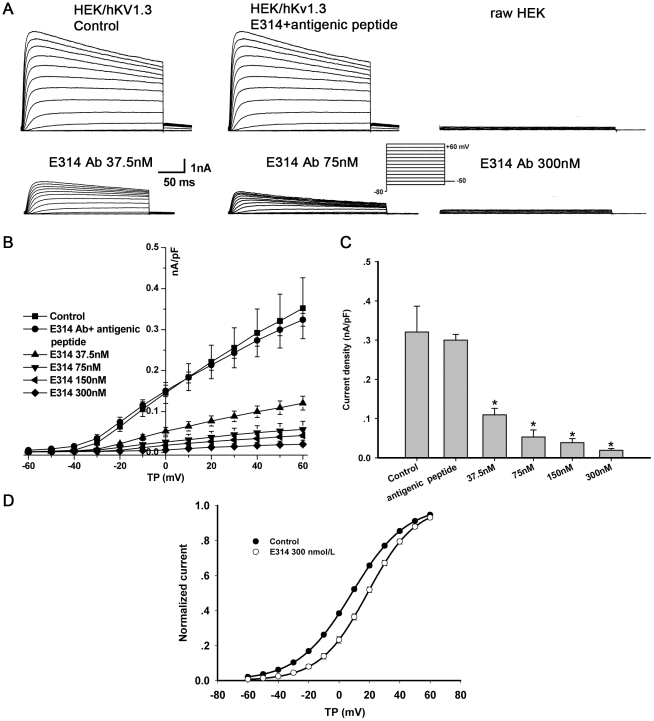
The E314 antibody inhibits human Kv1.3 currents stably expressed in HEK 293 cells.(A) IKv1.3 traces were activated at 0.1 Hz upon 250 ms voltage steps to between −60 and +60 mV (10-mV increment) from −80 mV with tail current at −50 mV in HEK 293 cells stably expressing hKv1.3 currents. The current was absent in raw HEK 293 cells. (B) The E314 antibody inhibited hKv1.3 currents in a concentration-dependent manner at test potentials from −30 to +60 mV and the inhibition was abolished by the E314 antibody preincubated with an excess of the E314 peptide, as shown in I–V relationship. (C) At depolarizing pulse +50 mV, the E314 antibody ranging from 37.5 to 300 nM inhibited hKv1.3 current density respectively by 66% (P<0.001), 84% (P<0.001), 88% (P<0.001) and 94% (P<0.001). (D) Steady-state activation relationships of hKv1.3 channels were fitted to a Boltzmann distribution: y = 1/{1+exp[(Vm-V0.5)/S]}, where Vm is the membrane potential, V0.5 is the midpoint, and S is the slope. V0.5 for activation conductance of IKv1.3 was 8.5±0.8 mV in control, and 18.7±1.0 mV in the 300 nM E314 antibody (n = 6, P<0.05). S was respectively 17.8±0.2 mV or 15.8±0.9 mV, for control and the 300 nM E314 antibody (P>0.05).